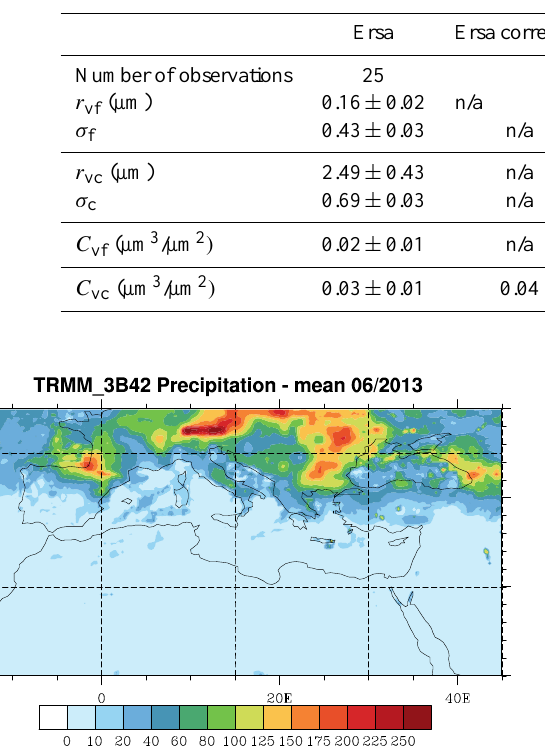
Figure 10. Monthly cloud cover and precipitation (over land only) derived from the Climate Research Unit (CRU) data for June 2013. Table 6. Main aerosol volume size distribution characteristics: r vf (µm), σ f , r vc (µm), σ c , C vf , and C vc , for the four different AERONET/PHOTONS stations: Ersa, Lampedusa, Cagliari and Cap d’En Font. C vi denotes the particle volume concentration, r vi is the median radius, and σ i is the standard deviation. Each average value in the table is accompanied by its standard deviation (this is not an accuracy of the retrieval). As mentioned in the text, the concentration of the coarse mode at Ersa has been corrected to be comparable to results at other stations closer to the sea surface, using the logarithmic law proposed by Piazzola et al. (2015).